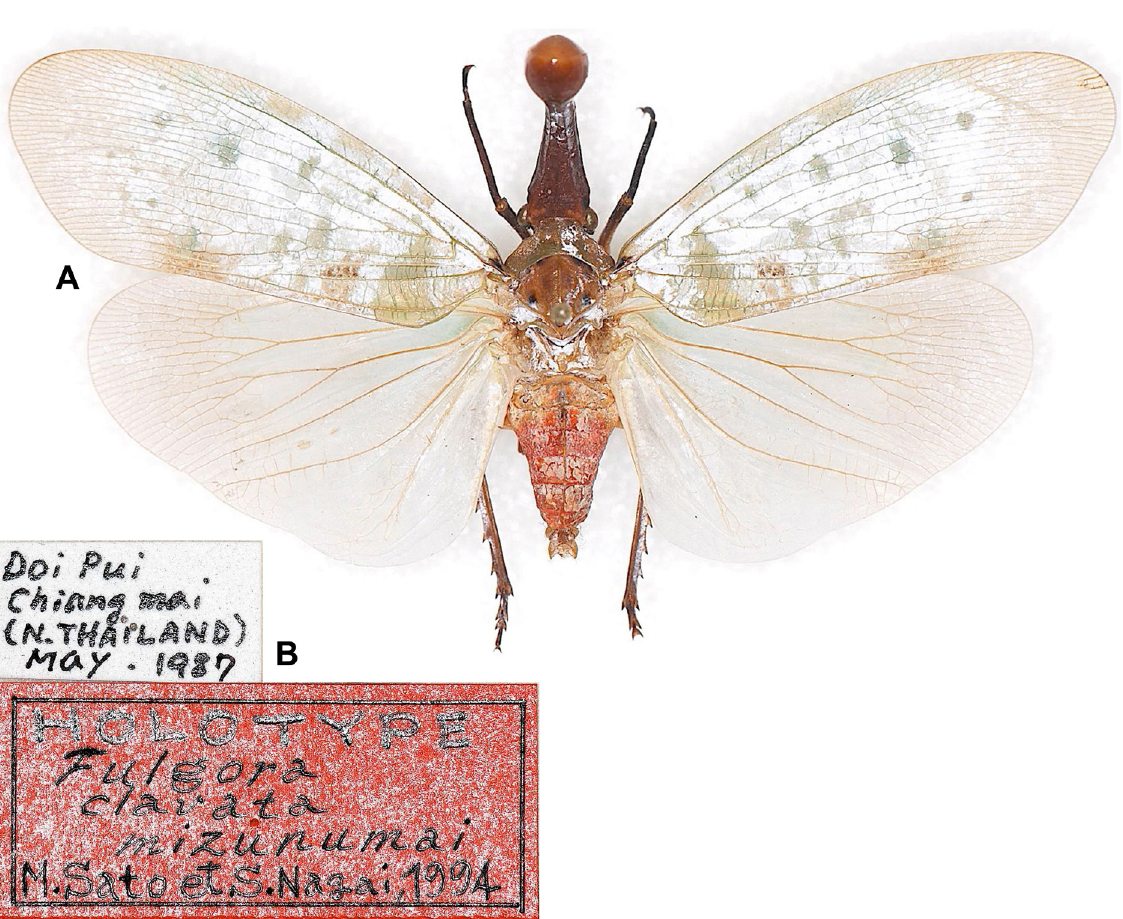
Fig. 15. Pyrops clavatus (Westwood, 1839), holotype, ♂ of the junior synonym Fulgora clavata mizunumai Sato & Nagai, 1994 (EUM, photographs by H. Yoshitomi). A . Habitus, dorsal view. B . Labels. Wingspan: